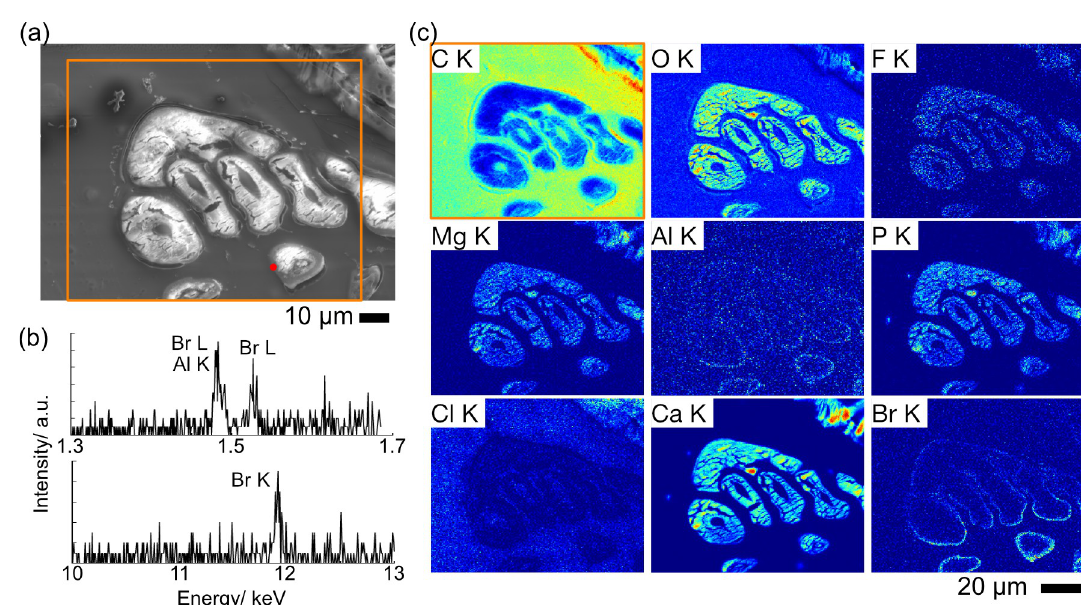
Fig 3. X-ray spectra and elemental maps of a semi-thin section of the gastric mill in Hirondellea gigas . a) SEM image of the mapped area. b) Point analysis at the red point in (a). c) WDS elemental maps of the orange rectangle in (a). Note that Al K contrast is significantly weaker than that of Br